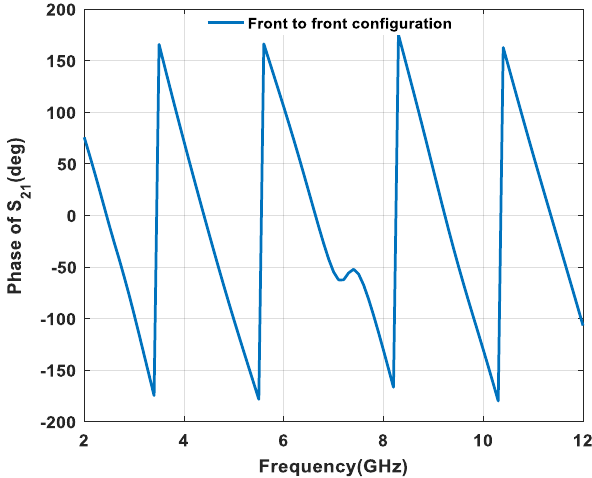
Figure 19. Phase variation effect of s 21 in front-to-front.